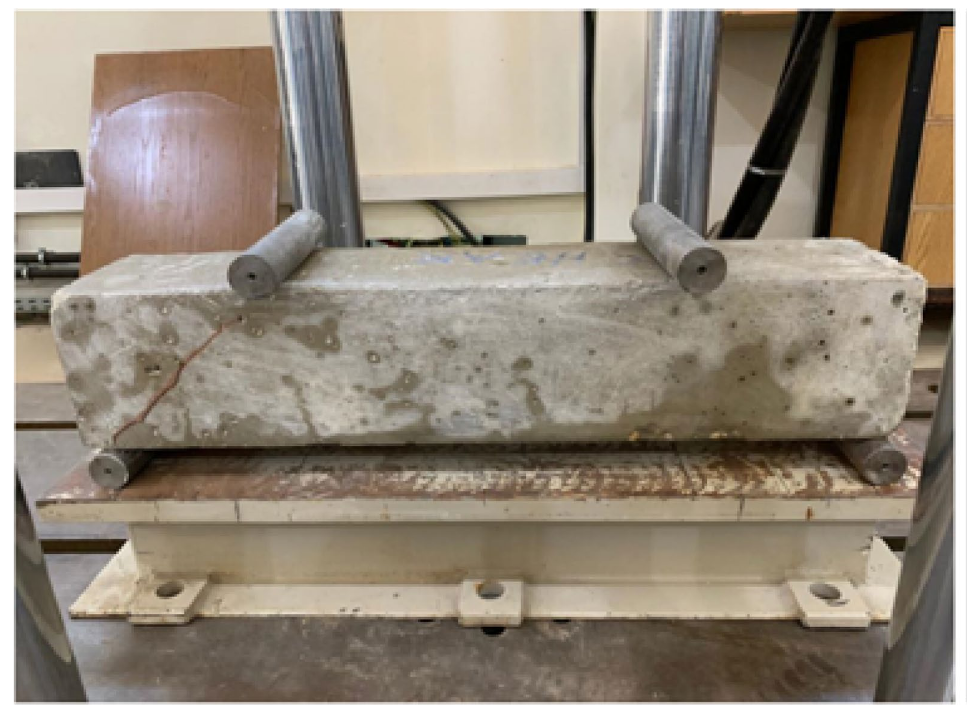
Fig. 10 Reference RC beam without